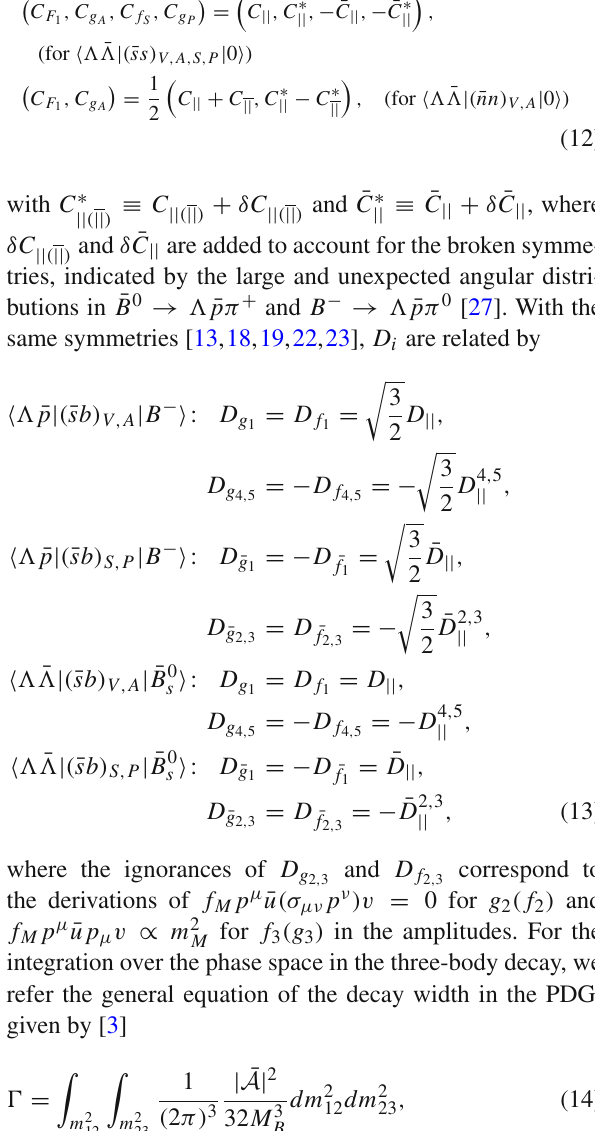
Table 2 Numerical results for B ( B − → (cid:3) ¯ p η ( (cid:3) ) ) and B ( ¯ B 0 s → (cid:3) ¯ (cid:3)η ( (cid:3) ) ) , with B ± =